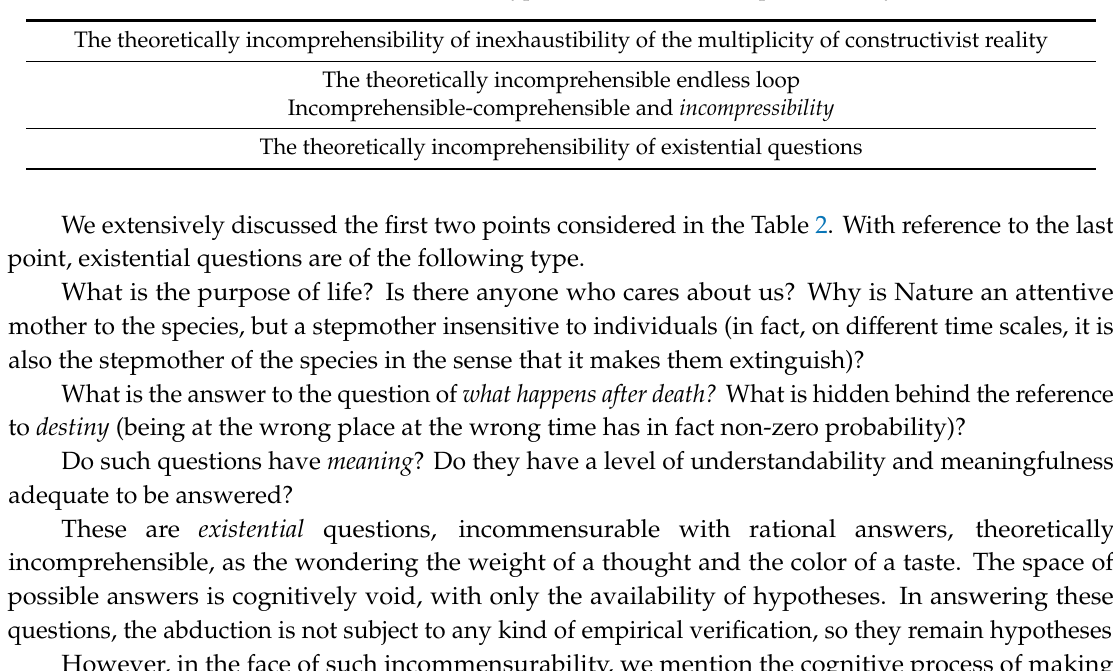
Table 2. Three fundamental types of theoretical